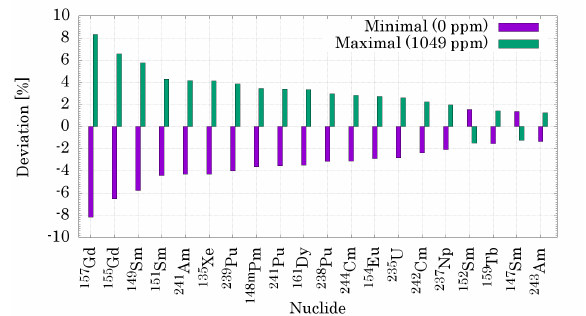
2 O 3 content on